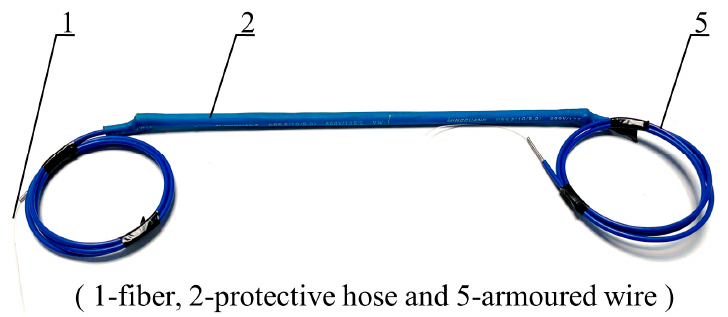
Figure 4. The real diagram of the fiber grating type thin rod vibration sensor.